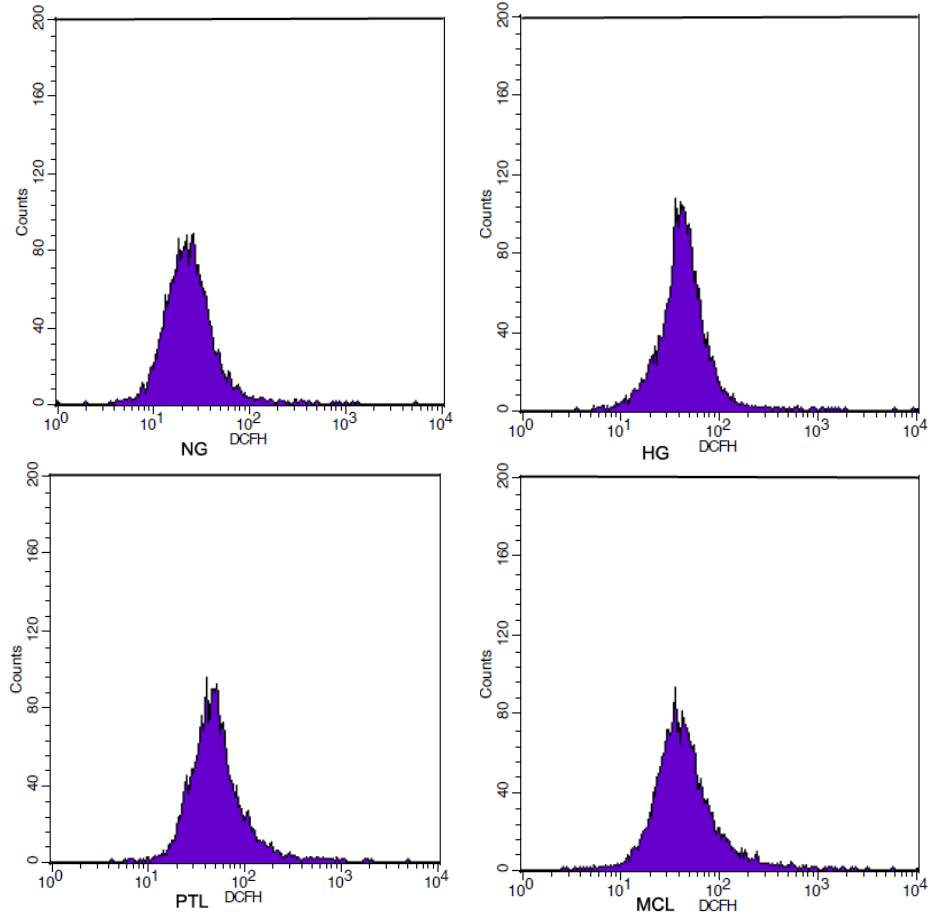
Figure 7. HG induces ROS production in MCs, MCs were pretreated with SLs before HG stimulation for 30 min. NG: normal glucose; HG: high